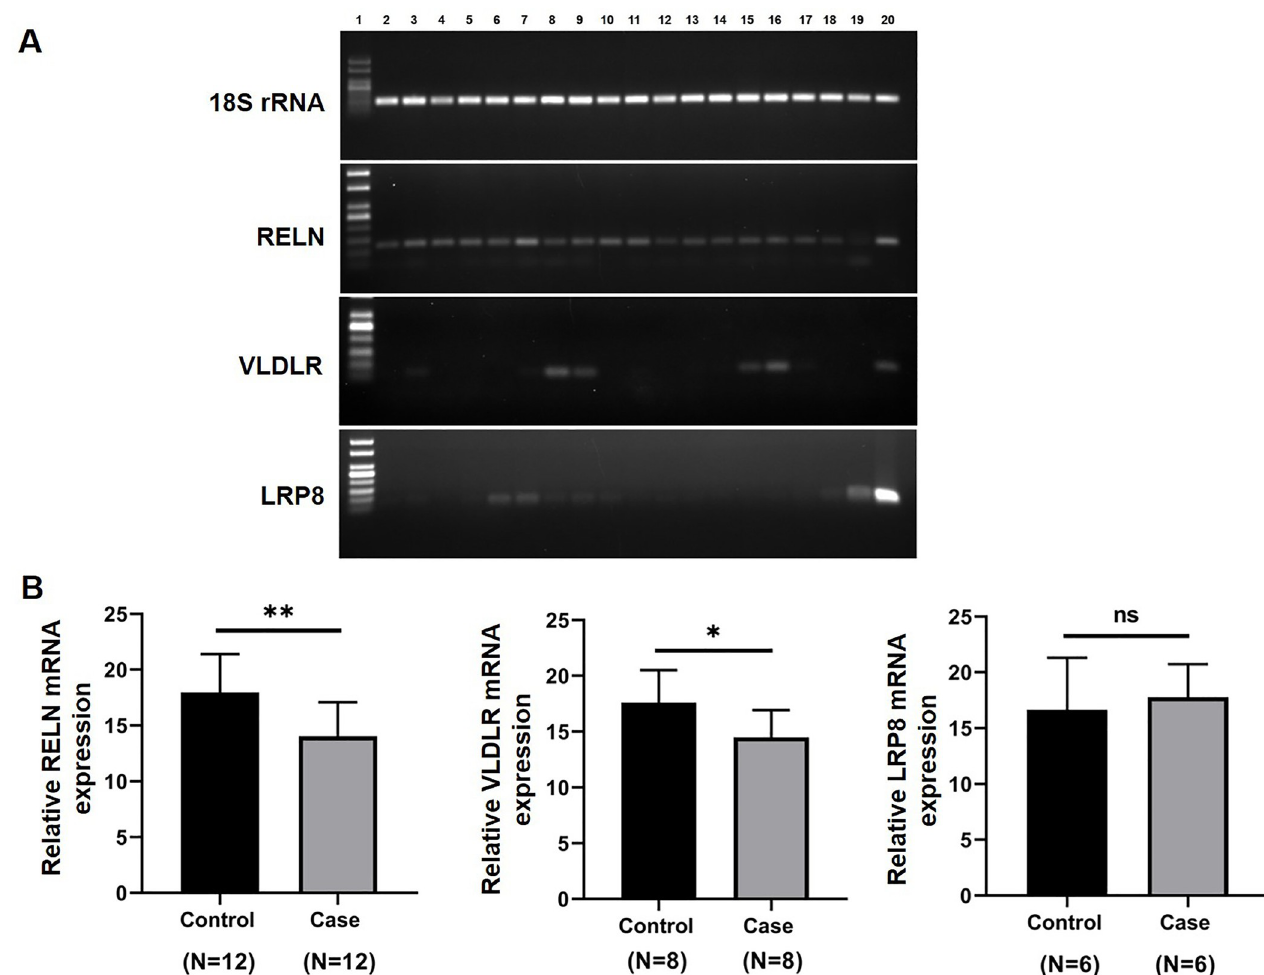
Fig 4. Comparison of mRNA expression of RELN , VLDLR and LRP8 genes in stapes tissues of cases and controls. (A) Agarose gel electrophoresis of molecular weight marker (Lane 1, 100 bp for 18S rRNA and RELN ; 50 bp for VLDLR and LRP8 ), RT-PCR products of 18S rRNA (151 bp), RELN (130 bp), VLDLR (88 bp), and LRP8 (74 bp) in mRNA derived from stapes tissues of cases (Lane 2–10), controls (Lane 11–19) and incus bone (Lane 20). (B) Expression levels were quantified by RT-qPCR and normalized to 18S rRNA expression. RELN expression was significantly lower in cases (p = 0.0068) compared to controls. VLDLR expression was found to be slightly lower in stapes tissues of cases (p = 0.0348) compared to controls. No remarkable change in LRP8 expression was observed between cases (p = 0.6172) and controls. Results expressed as mean ± standard deviation of mean. � p < 0.05, �� p < 0.01, ns = not significant.